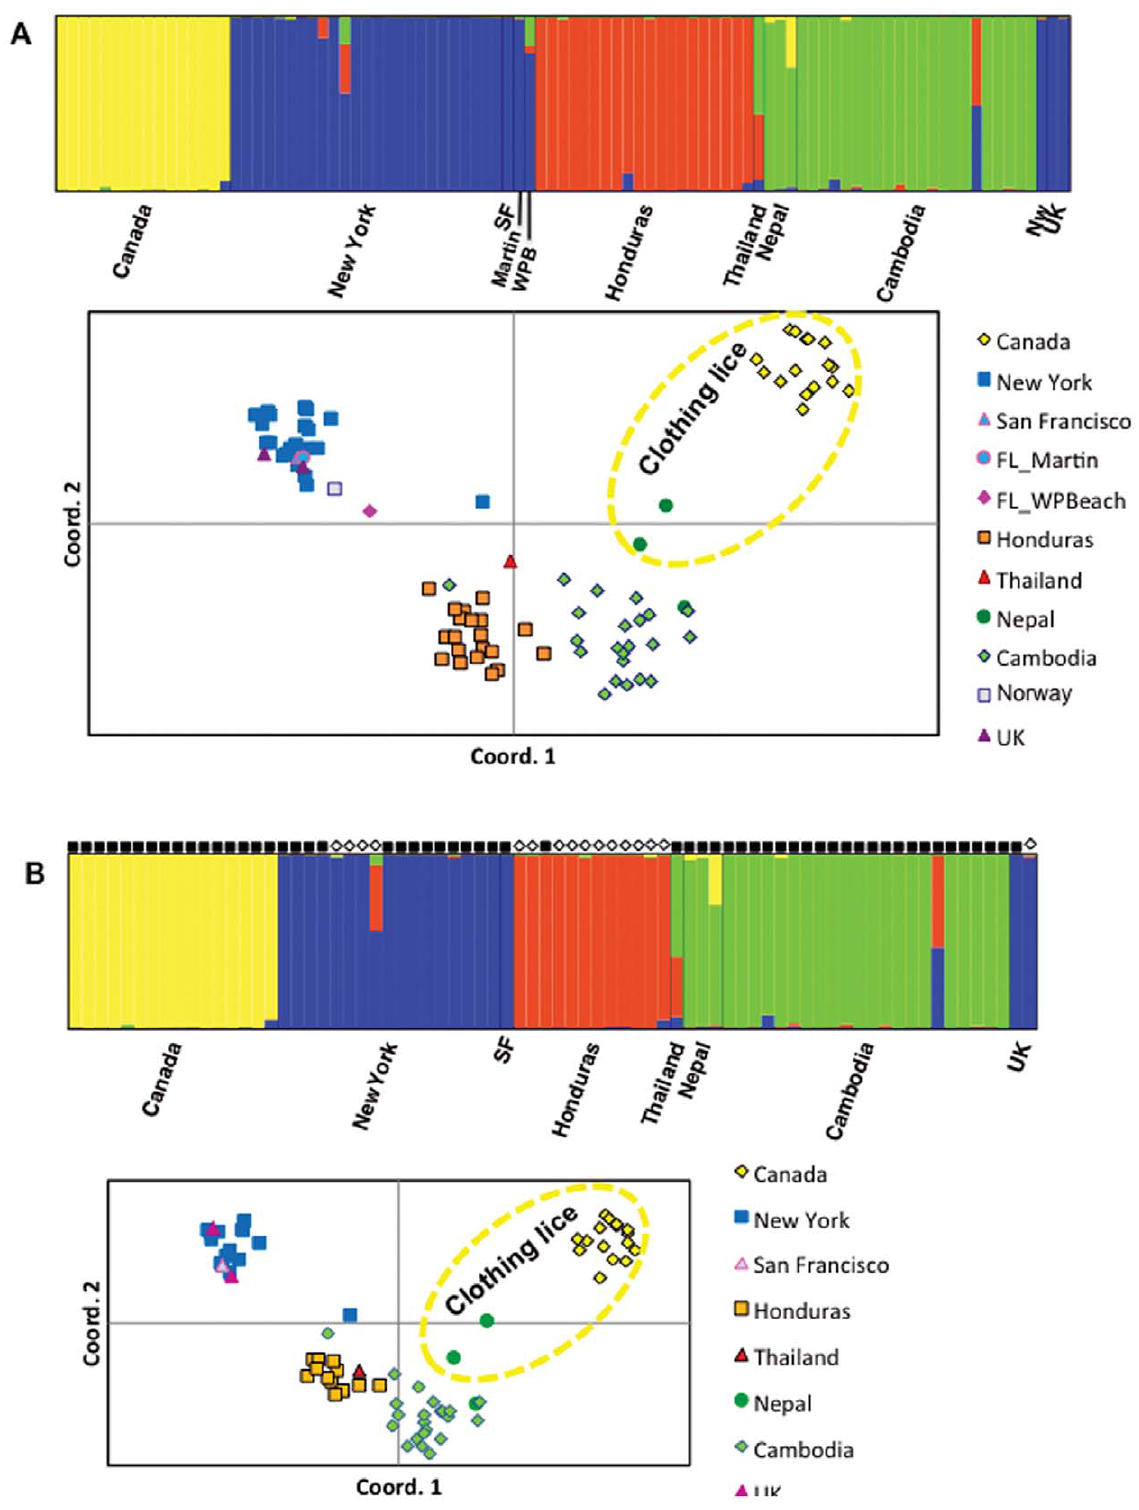
Figure 4. Genetic clusters inferred from STRUCTURE simulations ( K =4) for each dataset. A) the worldwide dataset for 14 loci (we excluded M2-13 due to missing data), and B) the worldwide dataset for all 14 loci plus the mitochondrial haplogroup coded as an additional locus. In the bar plot, each individual is represented by a single vertical line and the length of each color segment represents the proportion of membership ( Q ) to the four clusters. In pannel B, for each louse sample we added the mitochondrial haplogroup as filled black squares for Clade A and the open diamonds representing Clade B. Distributions of points in the first two dimensions resulting from principal coordination analyses (PCA) conducted using pairwise genetic distance comparisons of the same dataset used for the STRUCTURE analyses are below each STRUCTURE plot.